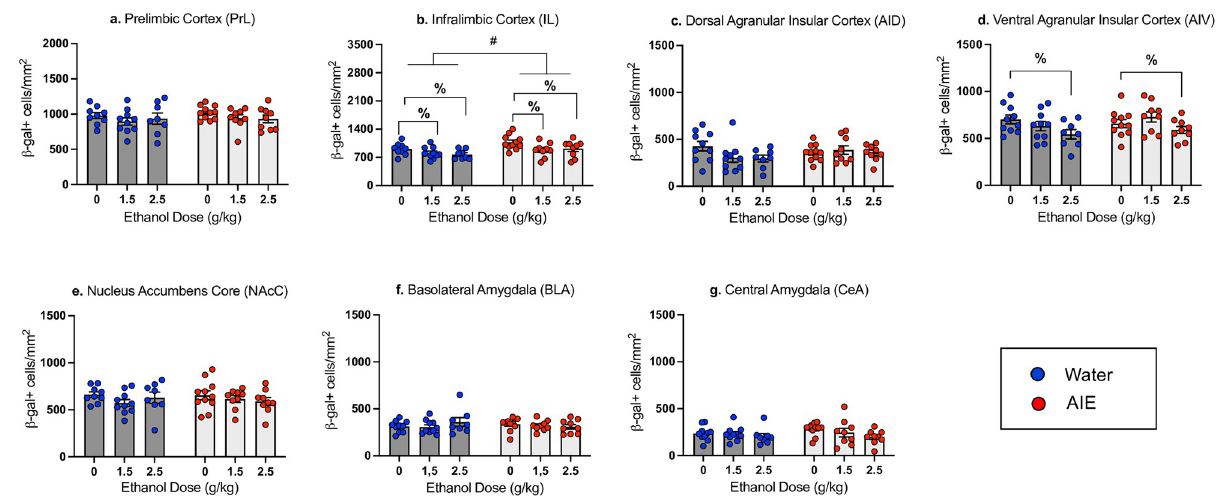
Fig 3. Neuronal activation indexed via number of β -gal+ cells in adults exposed to water or AIE. β -gal+ cell counts in the Prelimbic Cortex (a), Infralimbic Cortex (b), Dorsal Agranular Insular Cortex (c), Ventral Agranular Insular Cortex (d), Nucleus Accumbens Core (e), Basolateral Amygdala (f), and Central Amygdala (g) in adult males exposed to water or ethanol (AIE) during adolescence and previously conditioned with 0, 1.5 or 2.5 g/kg ethanol on test day following exposure to the CS (NaCl). n = 8-10/group; average number of slices per region for individual animal = 3–7. #—denotes main effect of Adolescent Exposure, %marks significant ethanol-associated changes relative to controls conditioned with with saline (0 g/kg ethanol dose) when collapsed across Adolescent Exposure (p < 0.05).